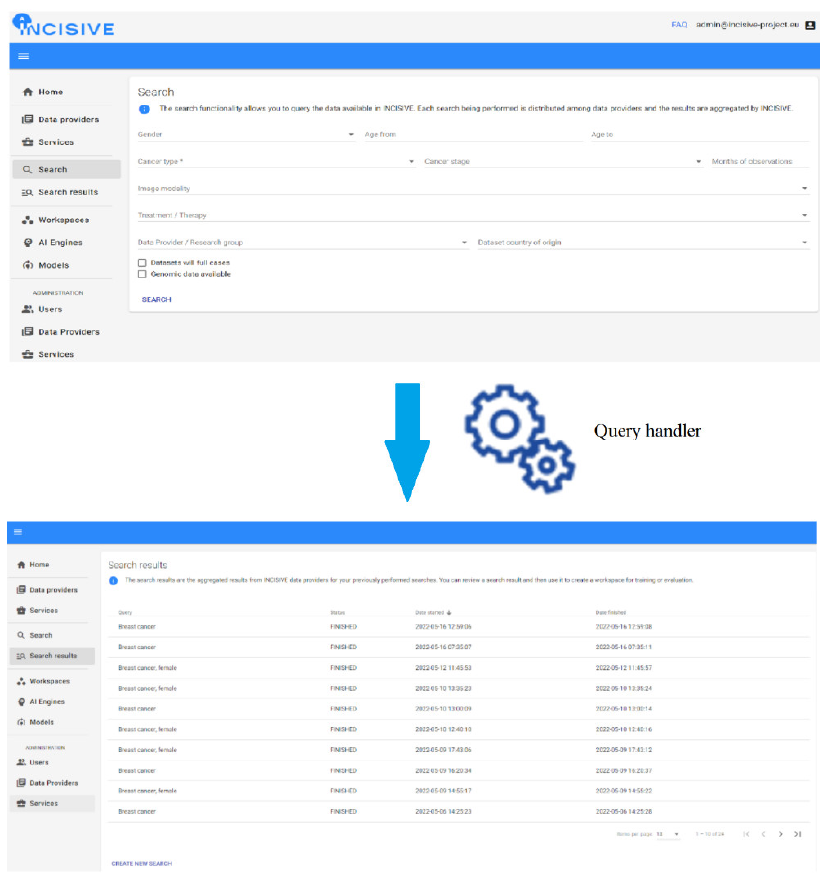
Figure 8. INCISIVE UI search process (data search and search results pages).